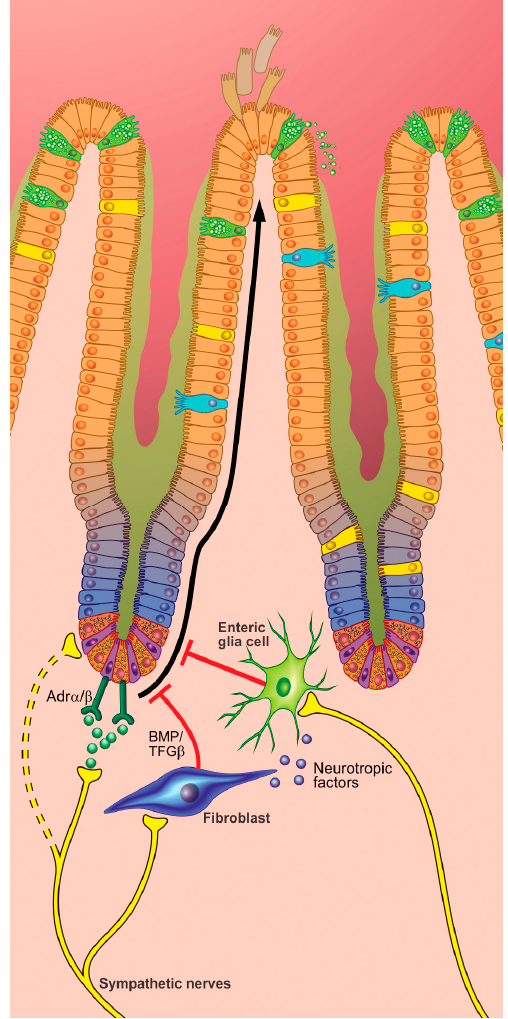
Figure 4. Proposed model of innervation of the intestinal crypt. Sympathetic nerves affect the proliferation in the crypt in multiple ways. Sympathetic neural activity inhibits proliferation through fibroblasts (that produce bone morphogenetic protein (BMP) and transforming growth factor (TGF- β )) and enteric glia cells that express adrenergic receptors. Enteric glia cells also produce neurotrophic factors that are critical in the growth, survival, and differentiation of nerves. In addition, adrenergic receptors are present on cells within the crypt, suggesting that sympathetic neural activity affects the proliferative processes directly.